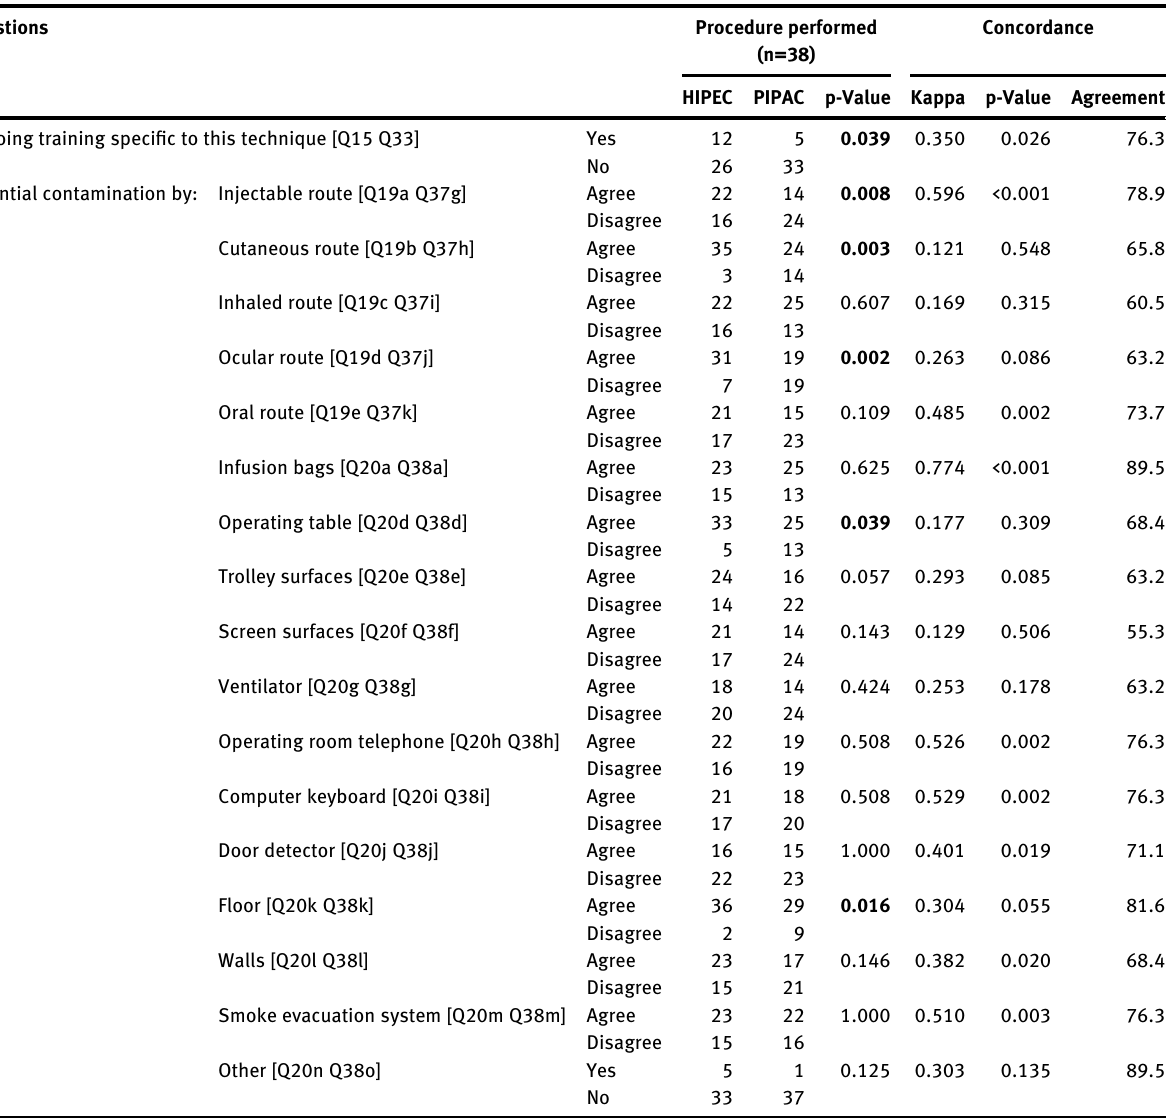
The bold values indicate a significant difference p <  . 